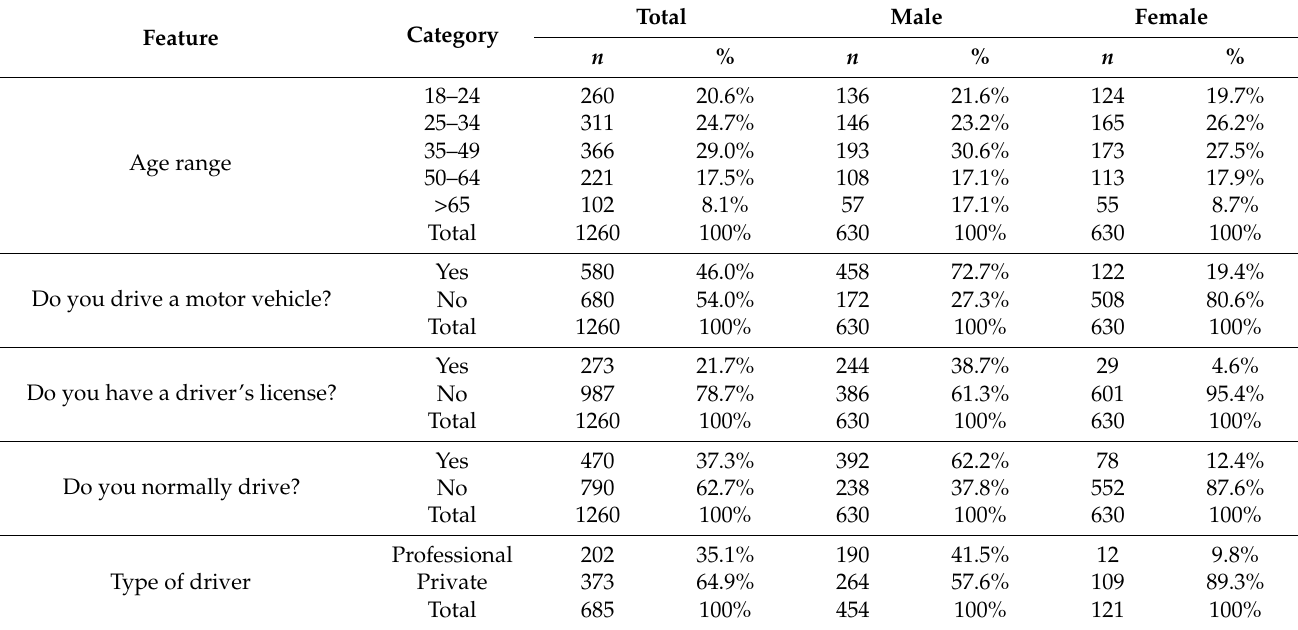
Table 1. Sociodemographic data of the